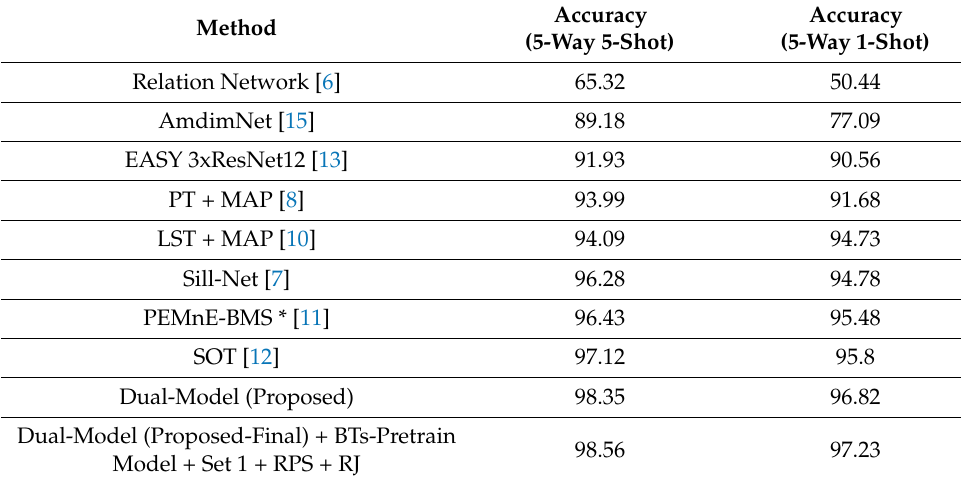
Table 5. Classification accuracy on CUB-200 (5-way 5-shot).